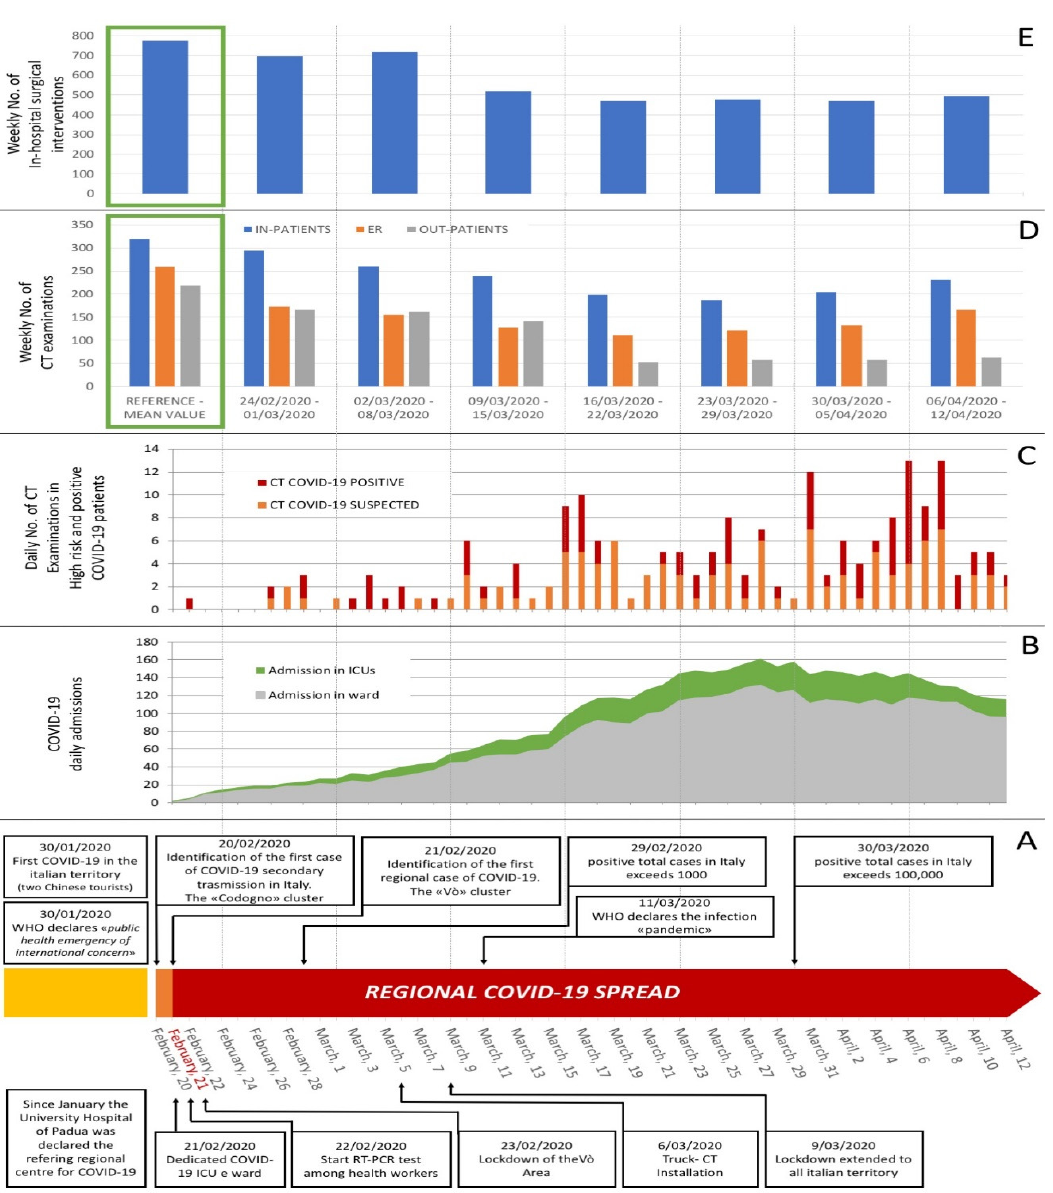
Figure 1. Hospital workload during Phase 1 of Coronavirus Disease 19 (COVID-19) pandemic, showing mean volume per day and week from 21 February through 12 April 2020, death of first patient in Padova area, and identification of the V ò cluster. The reference timeline highlighting the regional and national steps of the pandemic is represented in ( A ). Graph ( B ) shows the daily number of COVID-19 patients admitted to the Intensive Care Unit (ICU) and devoted wards. Graph ( C ) shows the total daily number of CT (Computed Tomography) examinations performed on COVID-19 positive or suspected patients. Graph ( D ) shows the total weekly number of CT acquisitions for in-patients, Emergency Room (ER) and out-patients during Phase 1 of the outbreak from Monday 24 February, and graph ( E ) shows the total weekly number of surgical interventions for in-hospital patients in the same period. Green squares in graph ( D ) and ( E ) identify, as a reference, the mean value of the benchmark performance of CT and surgical activities observed in the four weeks before the outbreak. Both CT scans and surgical interventions for in-patients are shown in